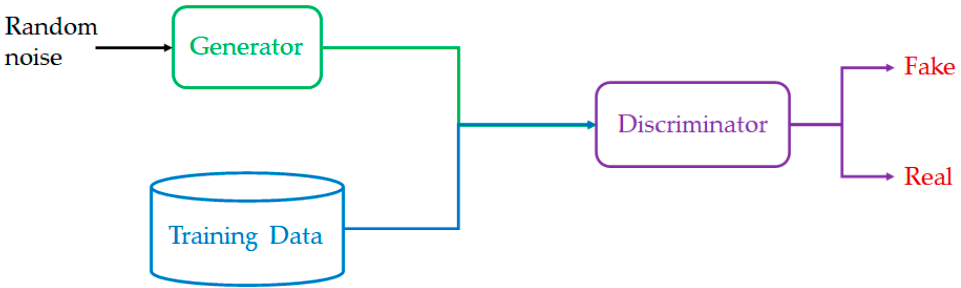
Figure 2. General architecture of GAN.